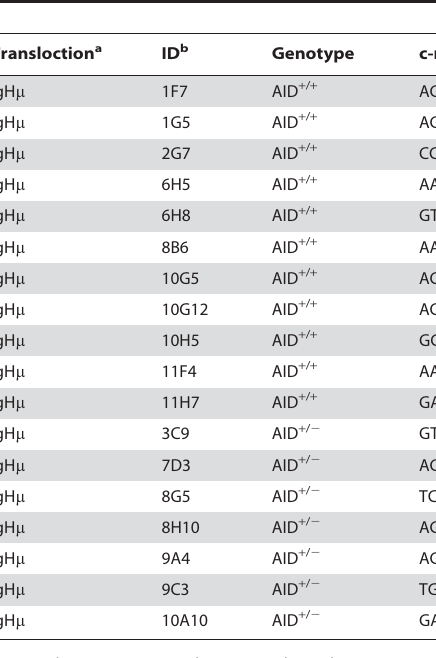
Table 2. c-myc/IgH chromosomal translocations generated in vitro